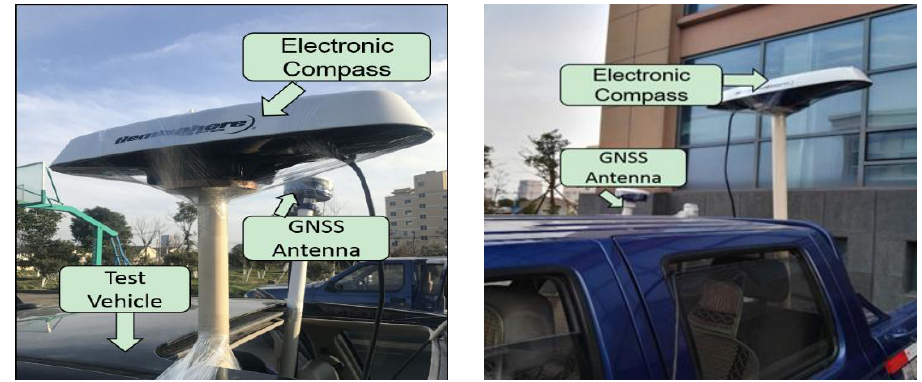
Figure 9. Equipment installation of the two vehicles. Test vehicle 1 ( left ) and Test vehicle 2 ( right ).